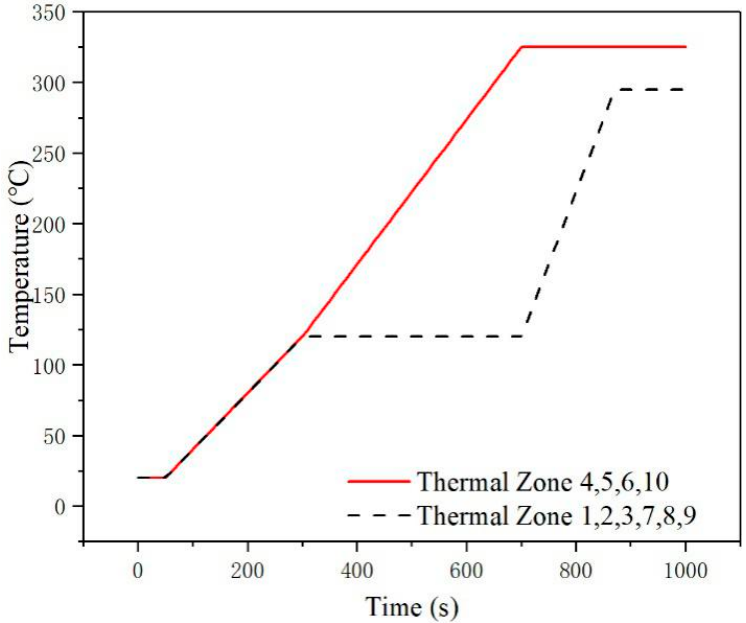
Figure 14. Temperature of each thermal zone in the designed condition.